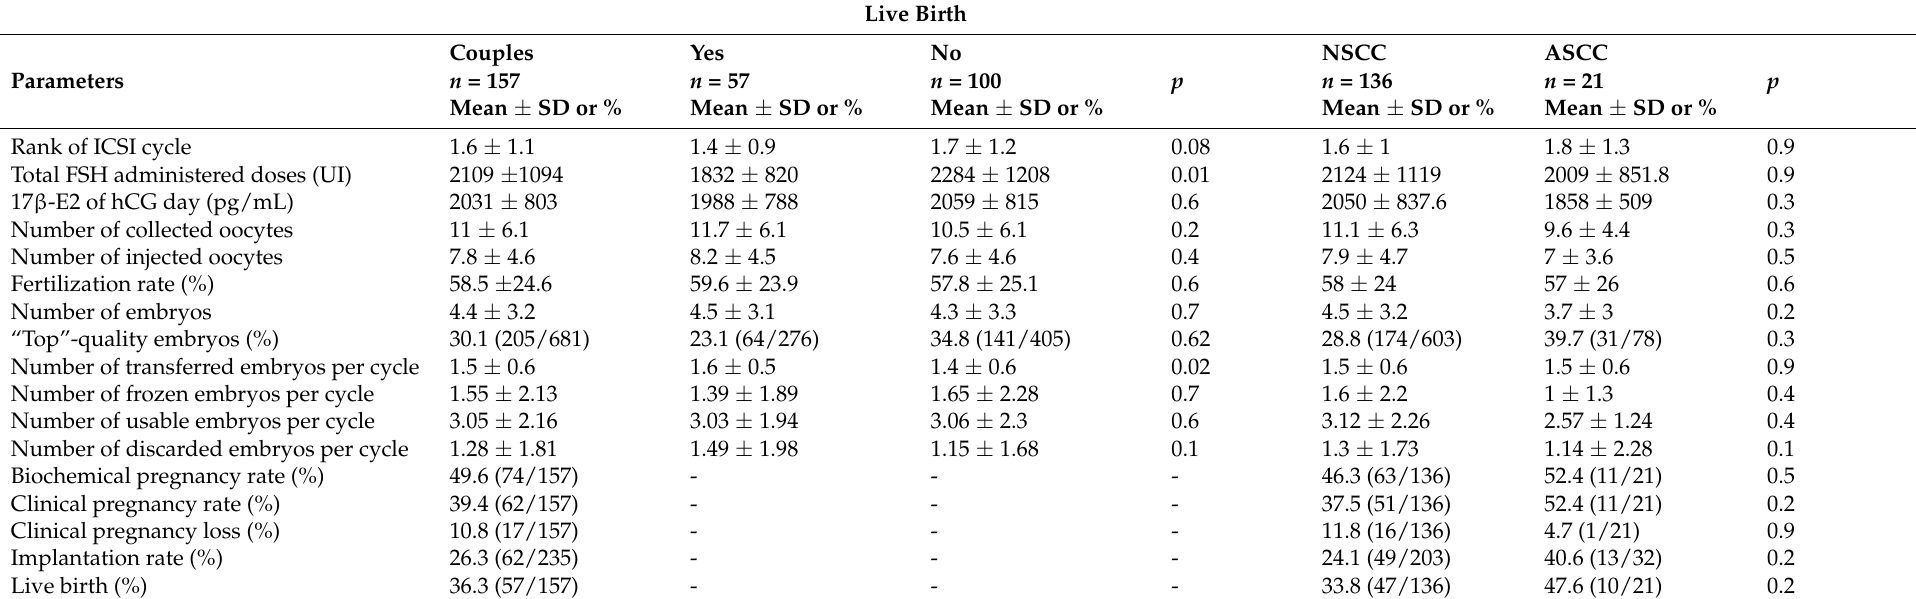
Table 2. ICSI cycle parameters according to live birth outcome and sperm chromatin condensation